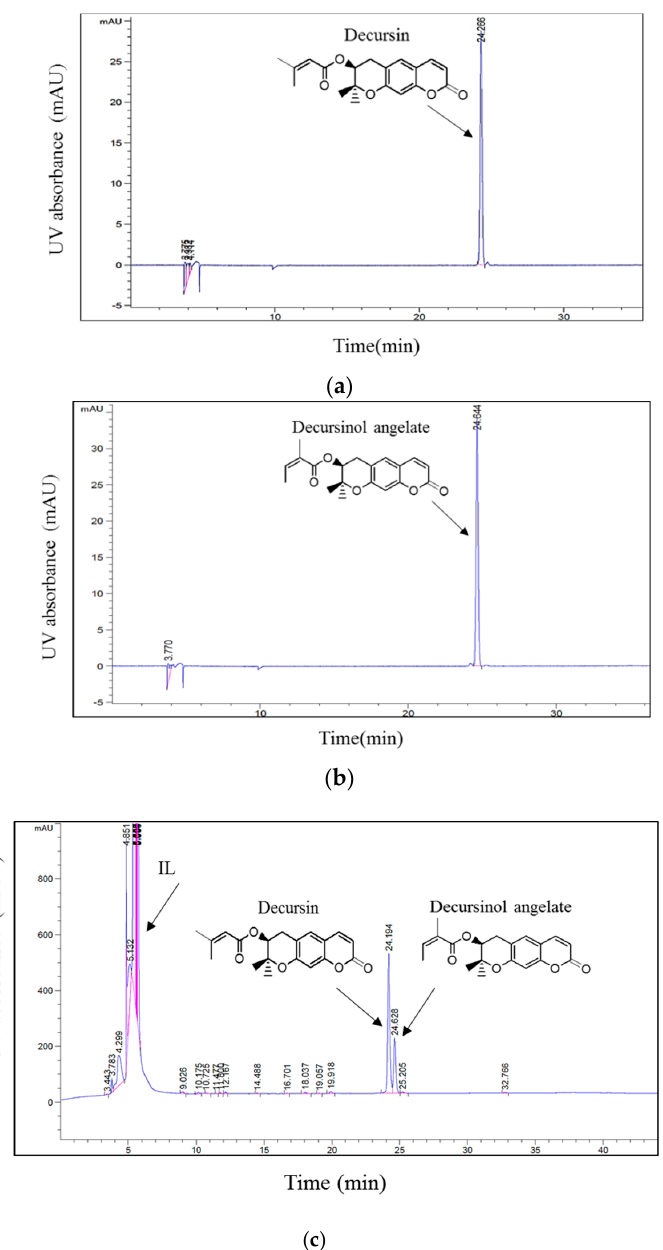
Figure 2. HPLC chromatograms of ( a ) D standard, ( b ) DA standard, ( c ) A. gigas –ionic liquid (IL) extraction solution. (UV 210